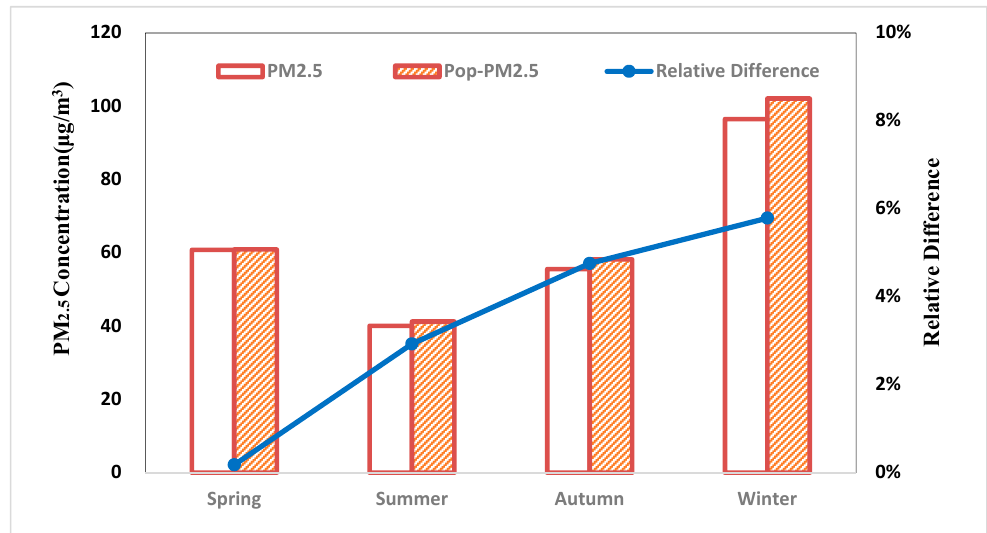
Figure 8. PM 2.5 concentration vs population-weighted PM 2.5 (Pop-PM 2.5 ) concentration and their relative difference in the YRD Region for the four seasons of 2013. Table 3. PM 2.5 concentration ( μ g/m 3 ) and Pop-PM 2.5 concentration ( μ g/m 3 ), and their difference